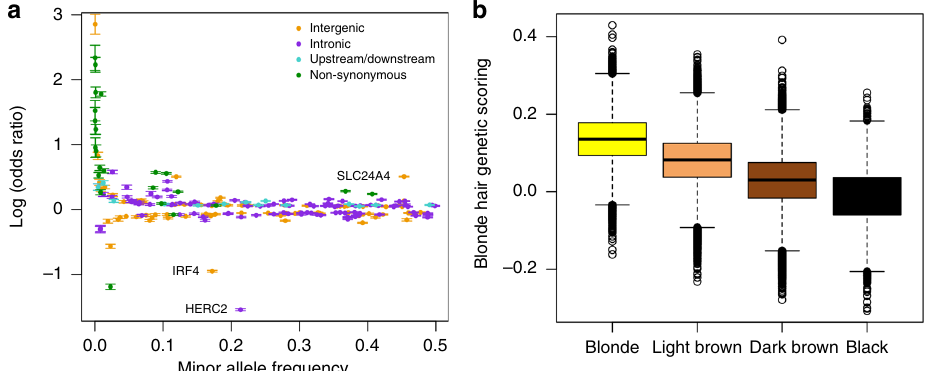
Fig. 4 Odds ratio and minor allele frequency for blonde hair and polygenic phenotype scores. a Plot of minor allele frequency of blonde hair-associated variants vs. log of the odds ratio for blonde hair. Variants are colour-coded for annotation; intergenic (yellow), intronic (purple), 2 kb upstream or 500 bp downstream (cyan), non-synonymous coding (green). Error bars indicate 95% con fi dence intervals in OR, according to the logistic model calculated with blonde vs. brown and black hair colour (blonde = 39,397, non-blonde = 283,920). b Genetic scores derived from all lead variants from blonde vs. brown plus black hair colour, assuming an additive genetic model. The line in the boxplot indicates the median value and the error bars the 95% of the data (blonde: 39,397 individuals, light brown: 141,414 individuals, dark brown: 127,980 individuals and black: 14,526 individuals). Colours yellow, light brown, dark brown and black match the hair colour Table 7), 28 of which are the same associated variant with blond hair and with the same direction of effect. Of the remaining lead variants 23 identify the same genes seen in our blonde hair analysis, and further 3 are associated with red hair. Of the two novel genes, KRT31 lies within a large locus encoding multiple keratin genes, in which we also observe associations with blonde hair. Only PIGU does not have a signi fi cant association with other hair colours, although we observe an association with another member of the same gene family, PIGV , suggesting that para- logous genes may be associated with hair colour differences. Additional GWAS of light brown and dark brown hair colours as expected identify more associations when light brown is com- pared to dark brown/ black than when brown is taken as a single category. Fewer associations are seen with dark brown alone vs. black (Supplementary Figures 9 and 10).